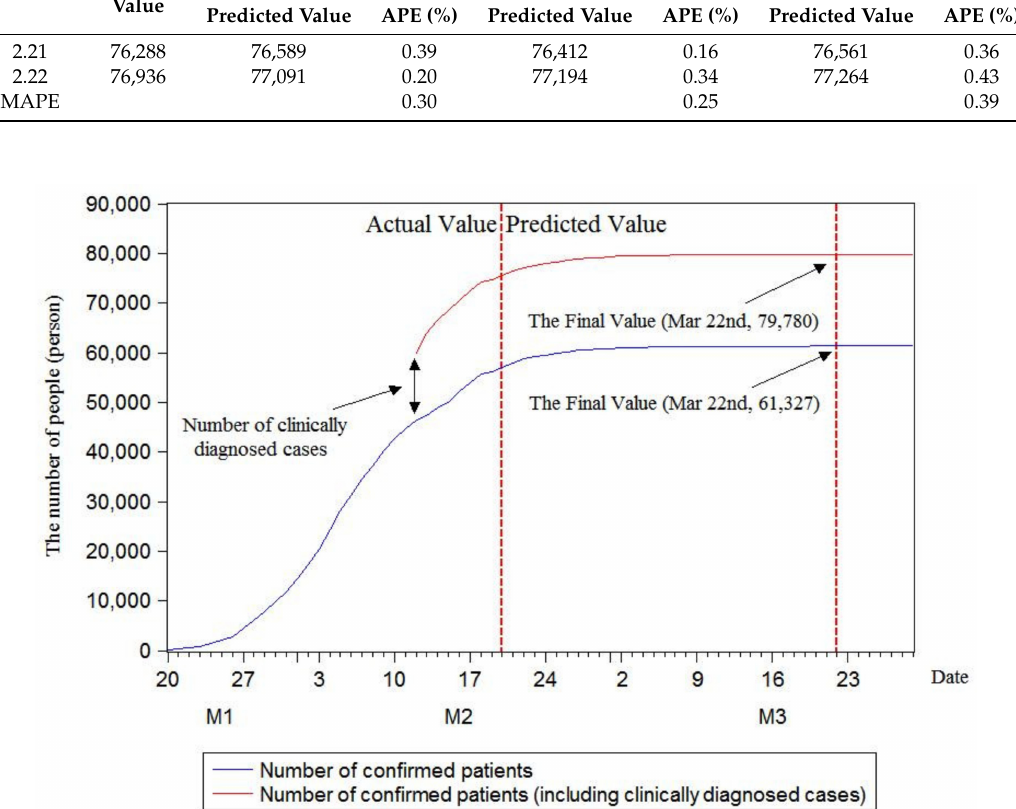
Figure 6. Model prediction with rolling sequence length of 8.